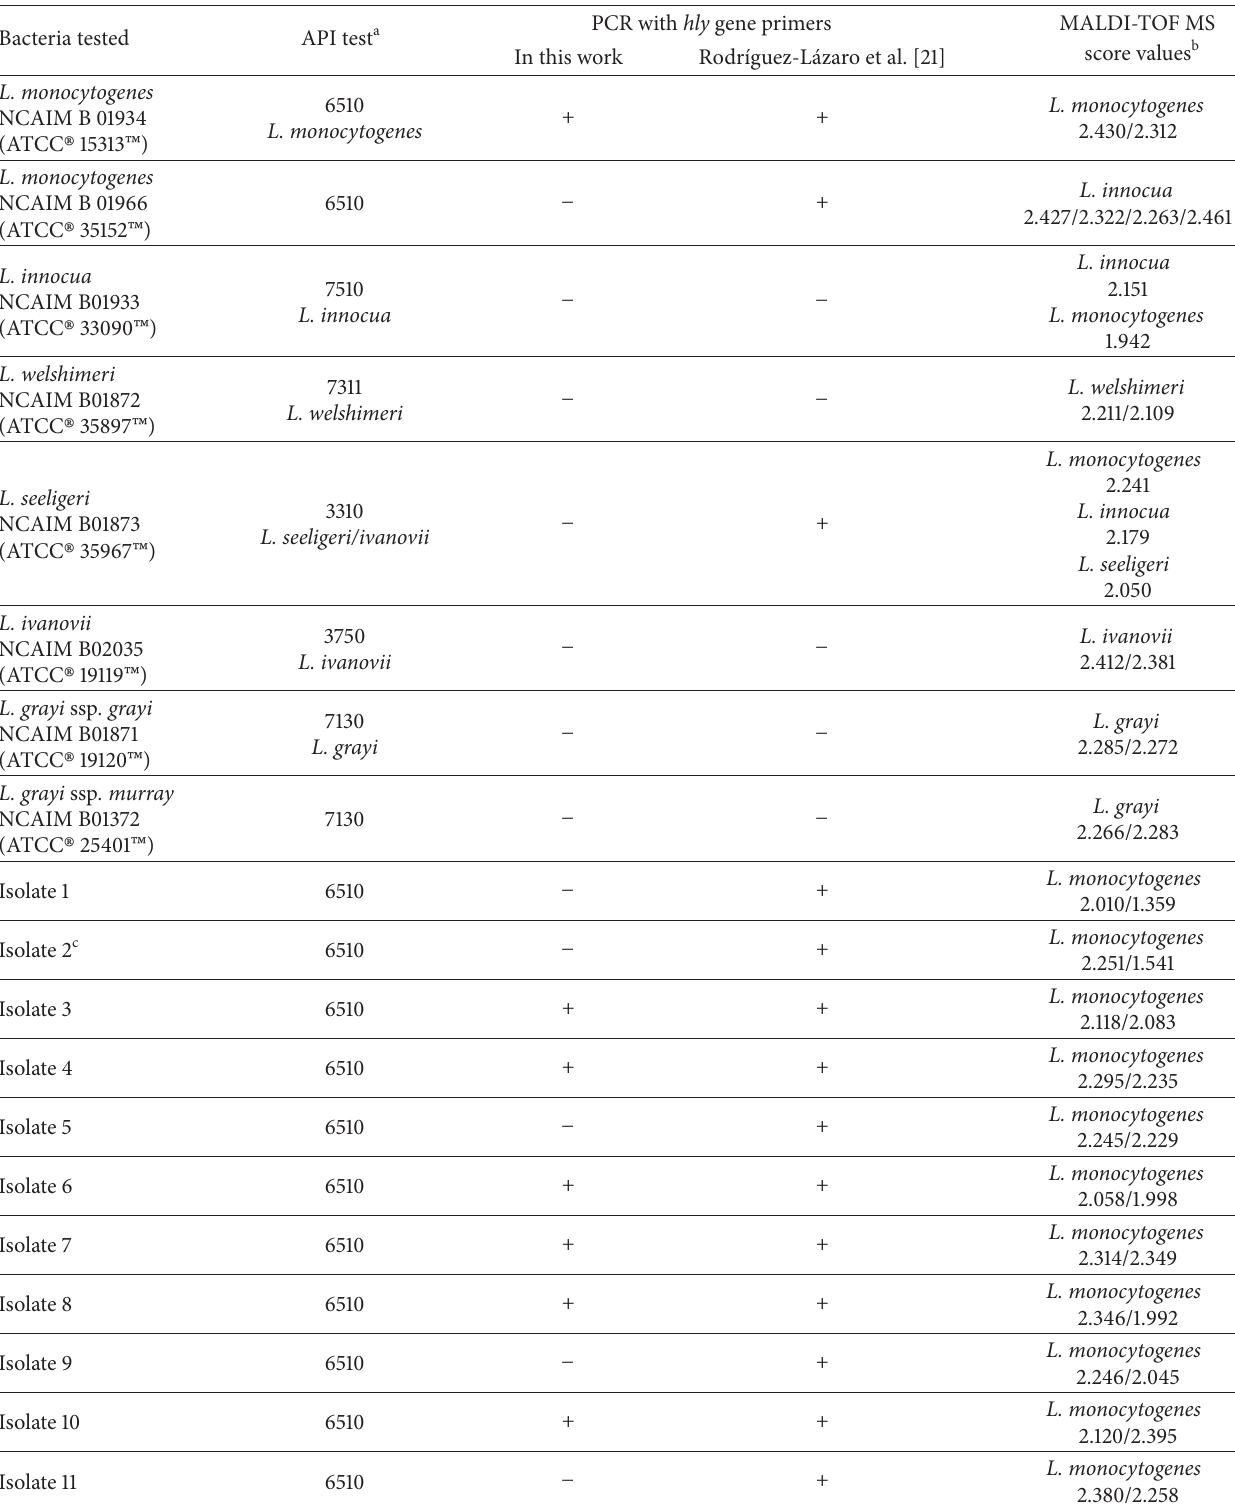
Table 1: Summary of the test results of the reference and foodborne Listeria